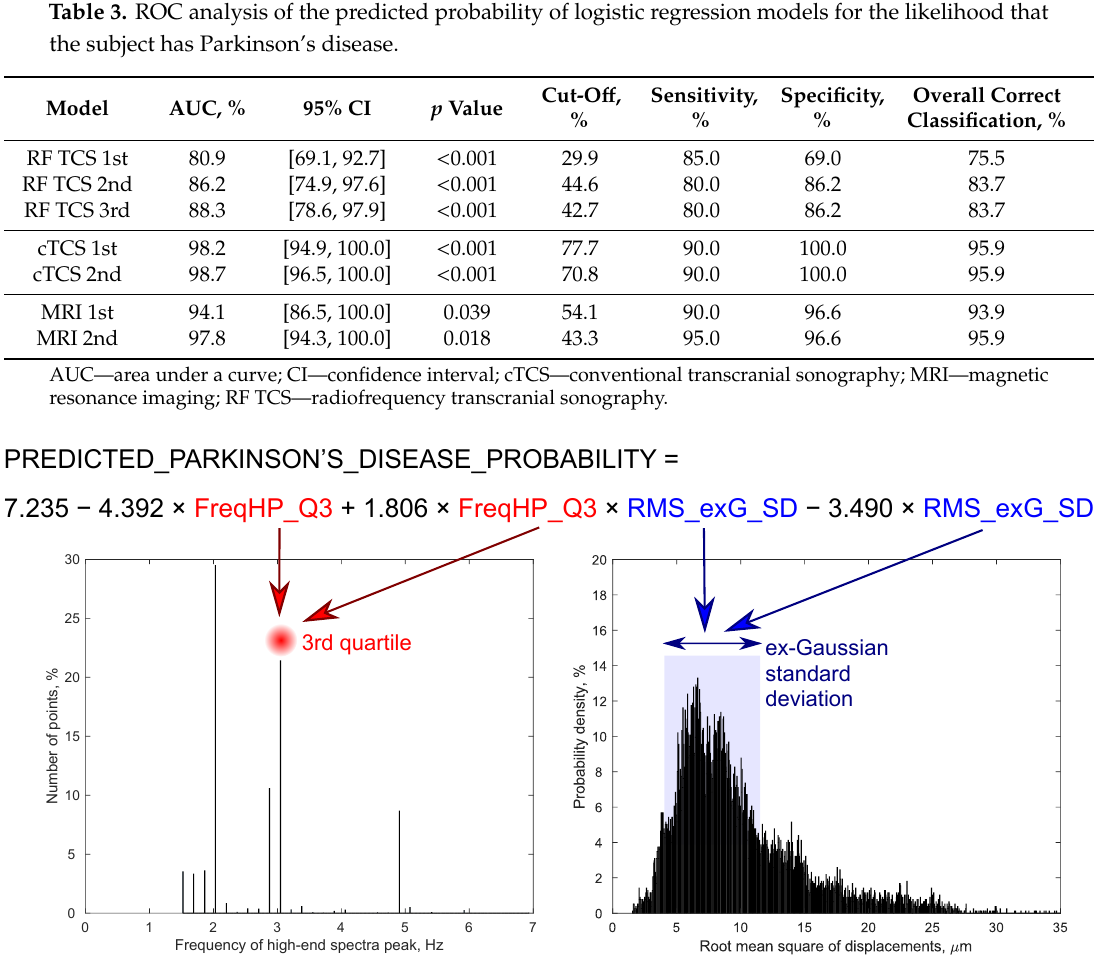
Figure 2. Visualization of radiofrequency ultrasound-based displacement parameter estimates that were included in the first logistic regression model. Sub-images represent distributions of displacement parameters of confidently repeatable moving individual points, from midbrain: ( a ) frequency of high-end spectra peak (FreqHP) and ( b ) root mean square (RMS). FreqHP_Q3—FreqHP third quartile, Hz; RMS_exG_SD—RMS standard deviation of ex-Gaussian distribution, µ